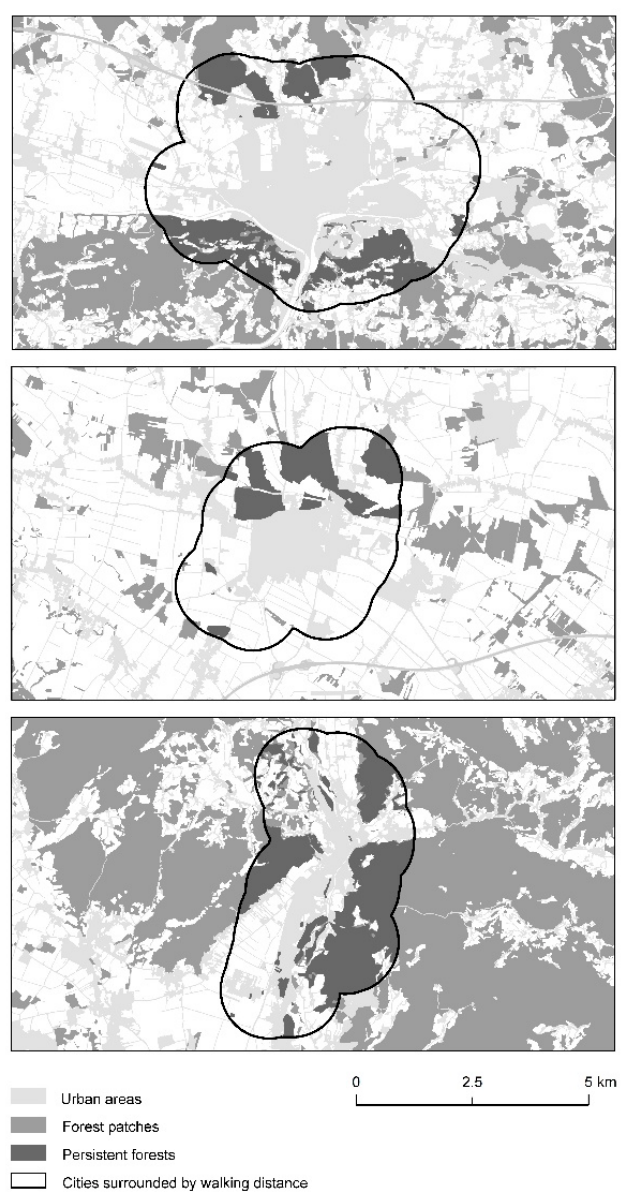
Figure 2. Maps of the selected study areas (Celje, Murska Sobota, Kamnik) with urban areas and forest patches. Cities are surrounded by a delineated area of a 1 km walking distance from the built-up area. Persistent forests represent the continuum of the natural environment in a 1 km walking distance area of the cities.